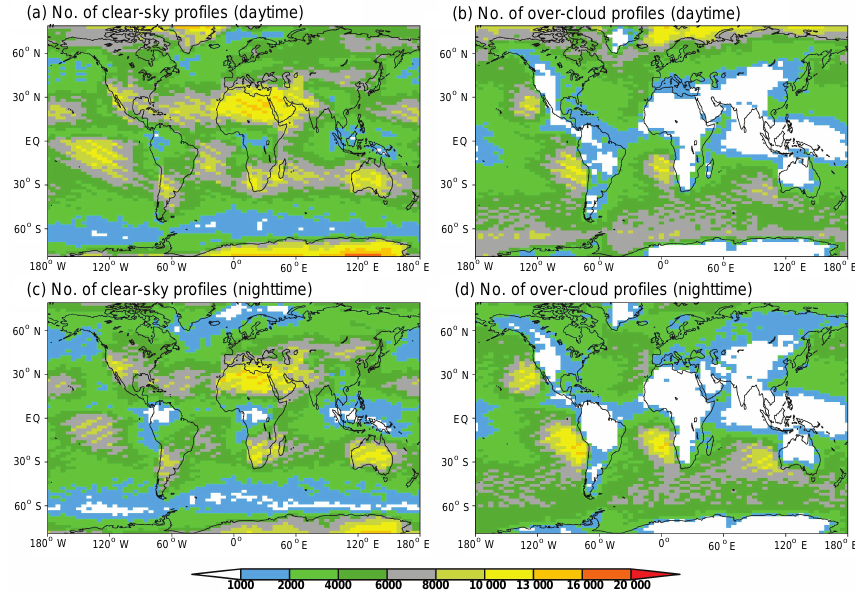
Figure 3. Number of profiles used for the analysis over each 2 ◦ × 5 ◦ latitude–longitude grid box. These numbers represent the total available profiles from June 2006 to October 2011.